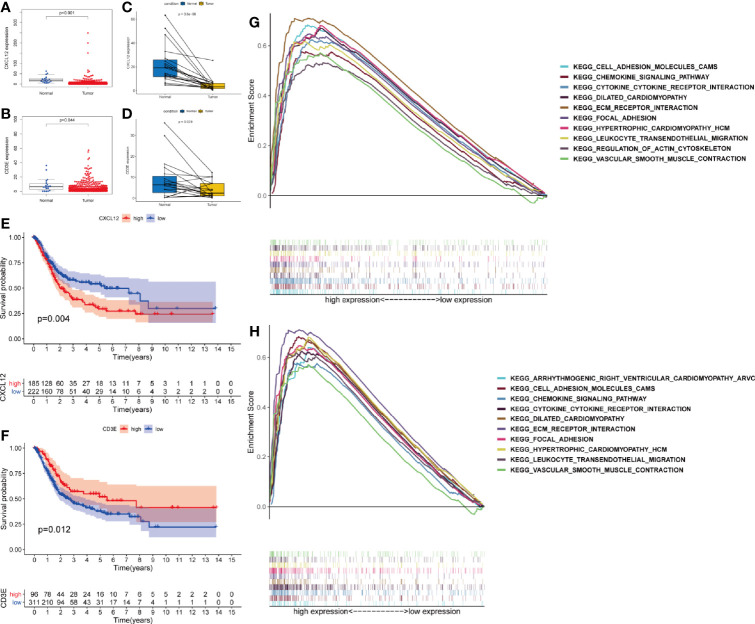
Validation the expression of CXCL12 and CD3E. Differently expressed CXCL12 (A) and CD3E (B) in normal tissue and in the tumor tissue. Similar result by paired analysis (C, D). Kaplan-Meier analysis for OS of bladder cancer (BLCA) patients based on the expression of CXCL12 (E) and CD3E (F). Gene set enrichment analysis of CXCL12 (G) and CD3E (H).